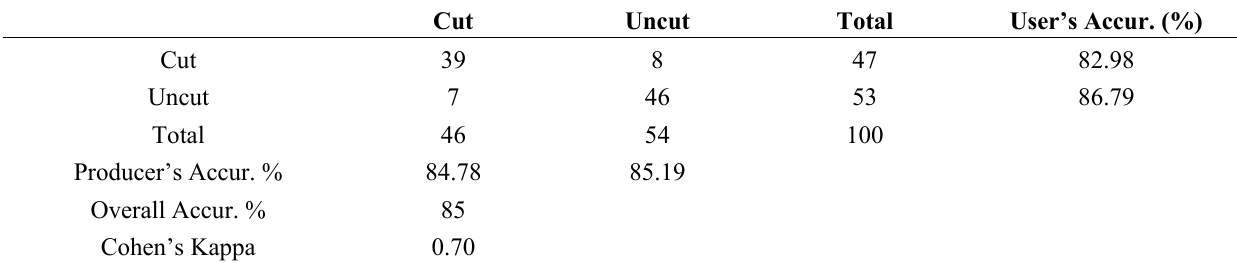
Producer’s Accur. %